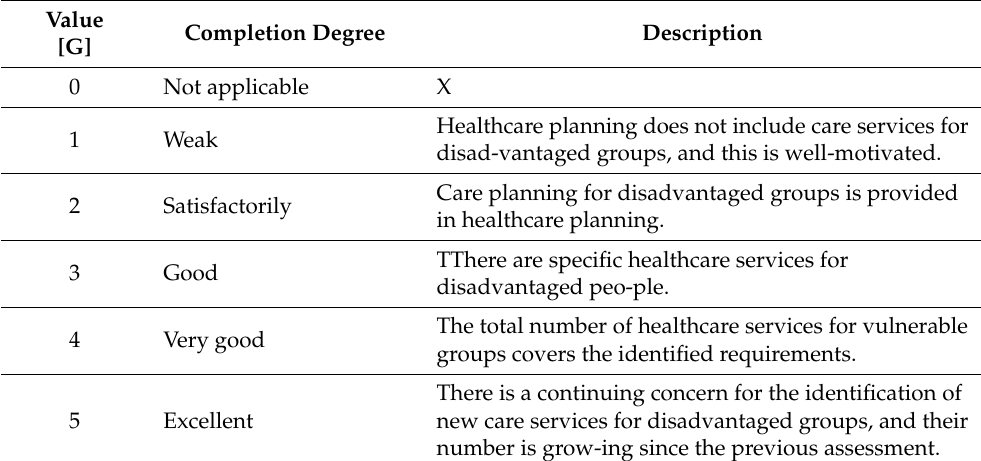
Table 6. Indicator evaluation grid P.A.2.2—Medical care services for disadvantaged